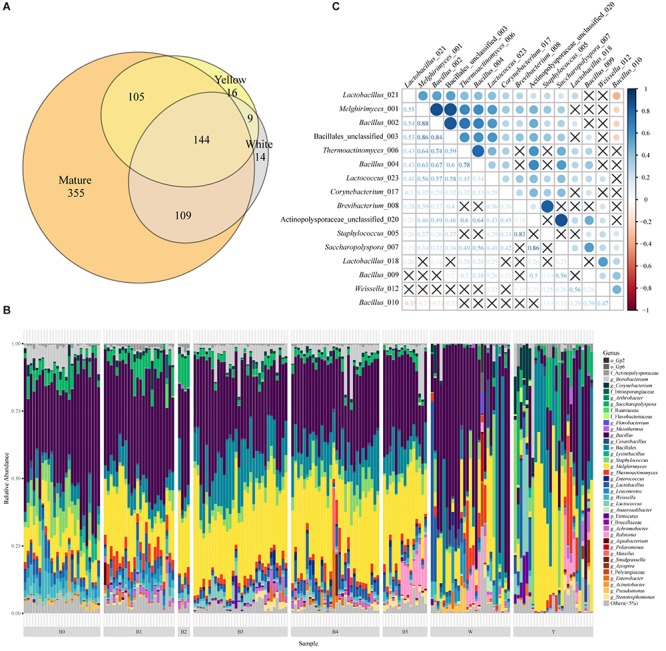
The taxonomic profile and important OTUs among Moutai starters (Daqu). (A) The Venn diagram of OTUs in yellow, white, and mature starters. (B) Taxonomic profile and the relative abundance of all 185 samples based on 16S rRNA metagenomic sequencing. Shown are the lowest taxonomic levels the OTUs can be annotated to, including phylum (p_), order (o_), family (f_), and genus (g_). “Others (<5%)” includes all taxa less than 5%. W and Y stand for white and yellow immature starters. B0 to B5 stands for six batches of mature starters. (C) The Spearman correlations between 16 core OTUs present in more than 95% mature starter samples (significance level is 0.05, P value is adjusted in the FDR method). The labels are composed of the taxa and the last three numbers of OTUs original names.